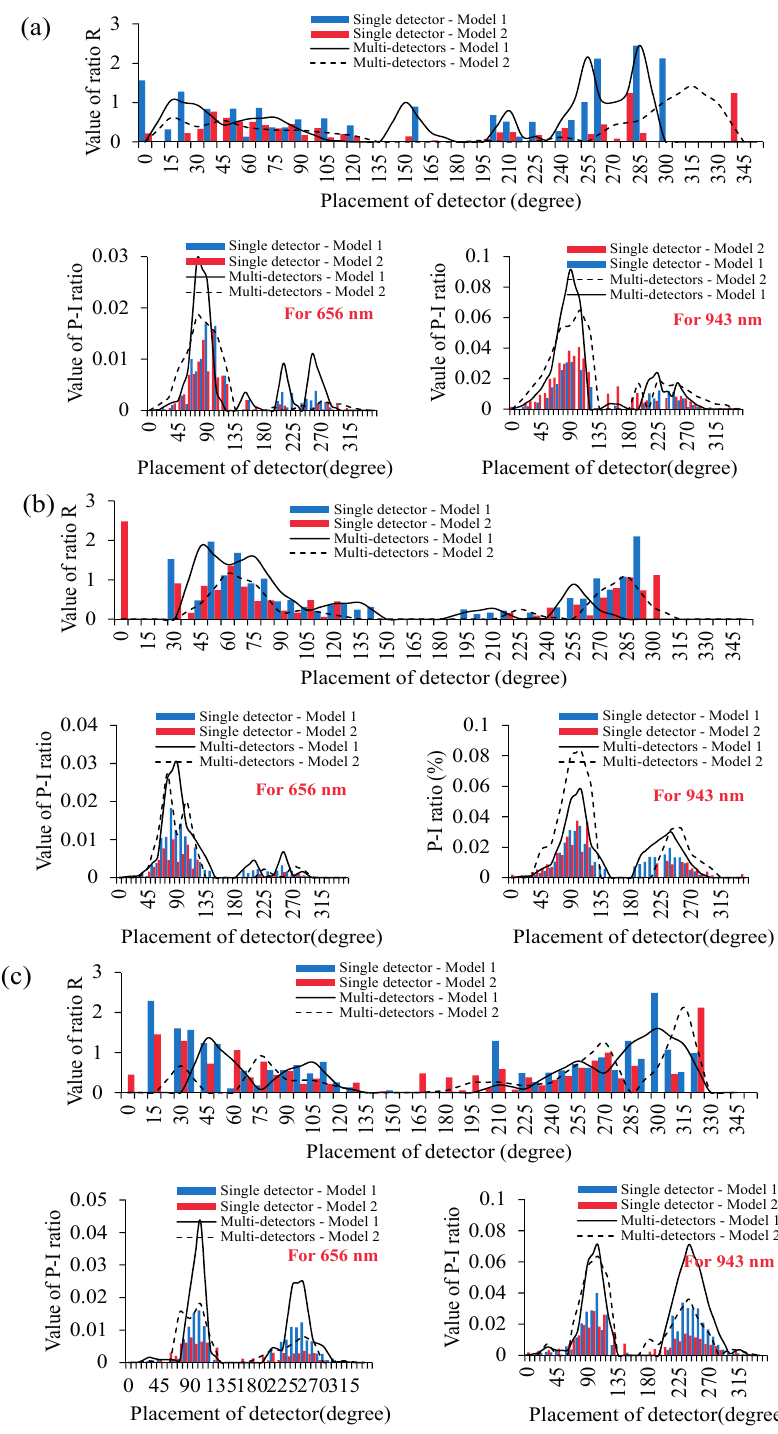
Figure 5. Comparisons of simulation results for the P-I ratio value and ratio R value by using a single detector and a multi-detector when the light source was placed at ( a ) 135°, ( b ) 150° and ( c ) 165°,